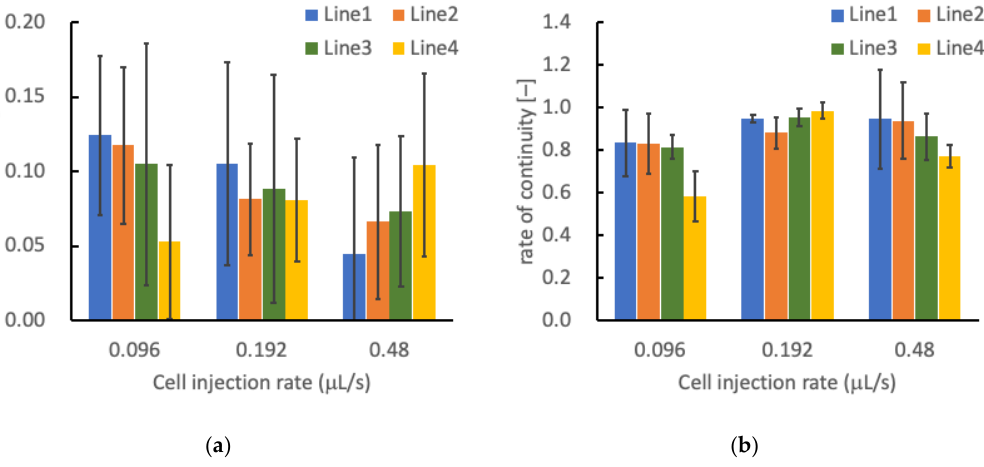
Figure 12. Relationships between cell injection rate and ( a ) neurite growth ratio, and ( b ) continuity ratio in square patterns of PC-12 cells. Mean ± S.D., n = 5.